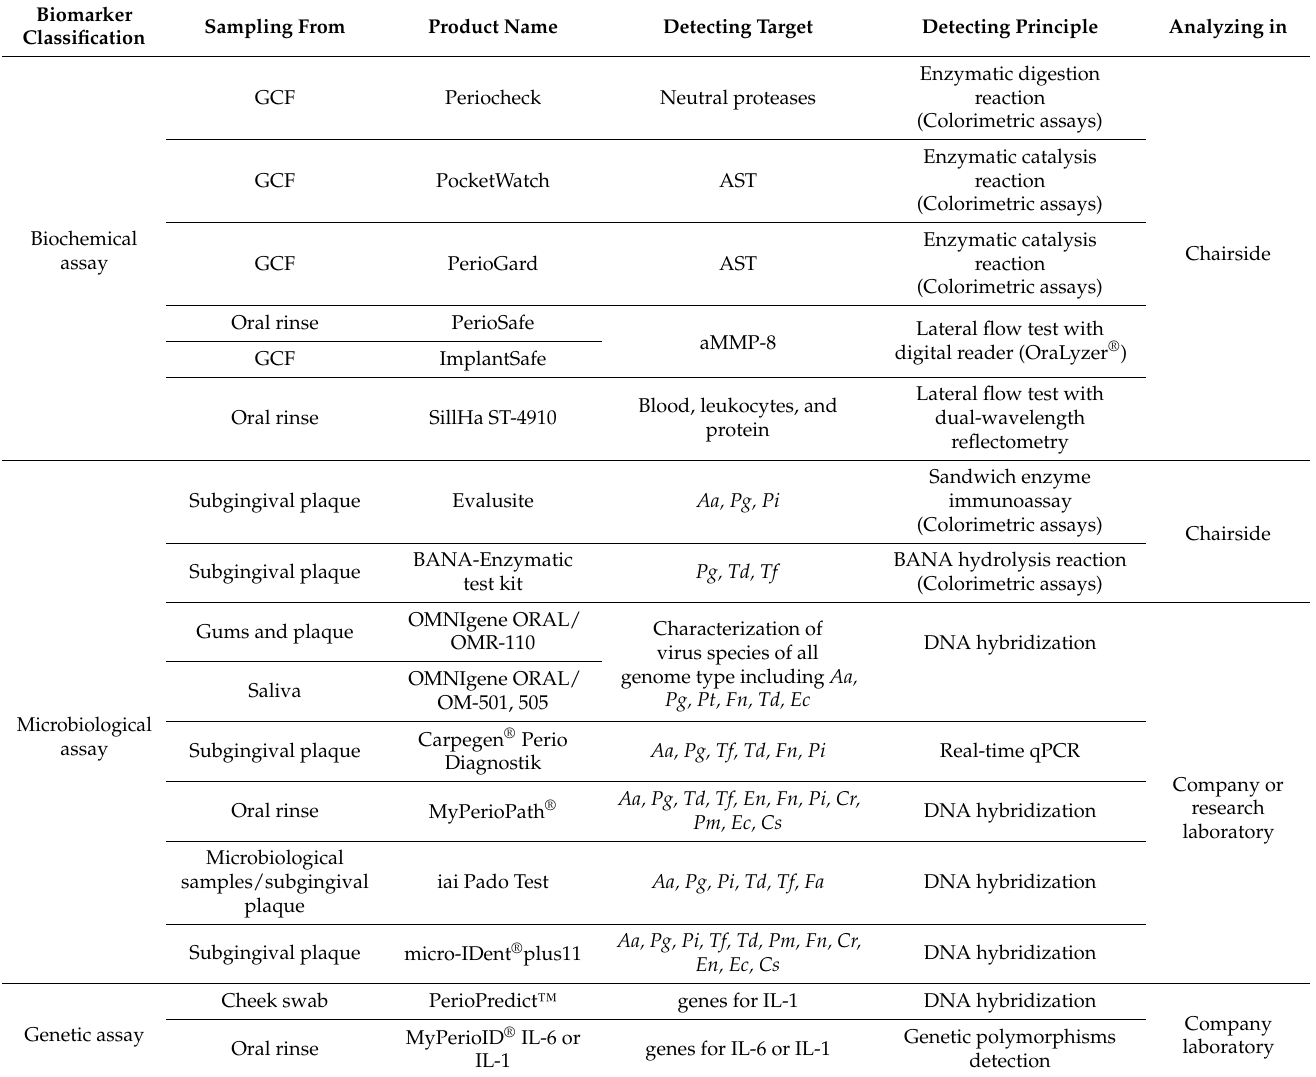
Table 2. Examples of biomarker assay kits in the